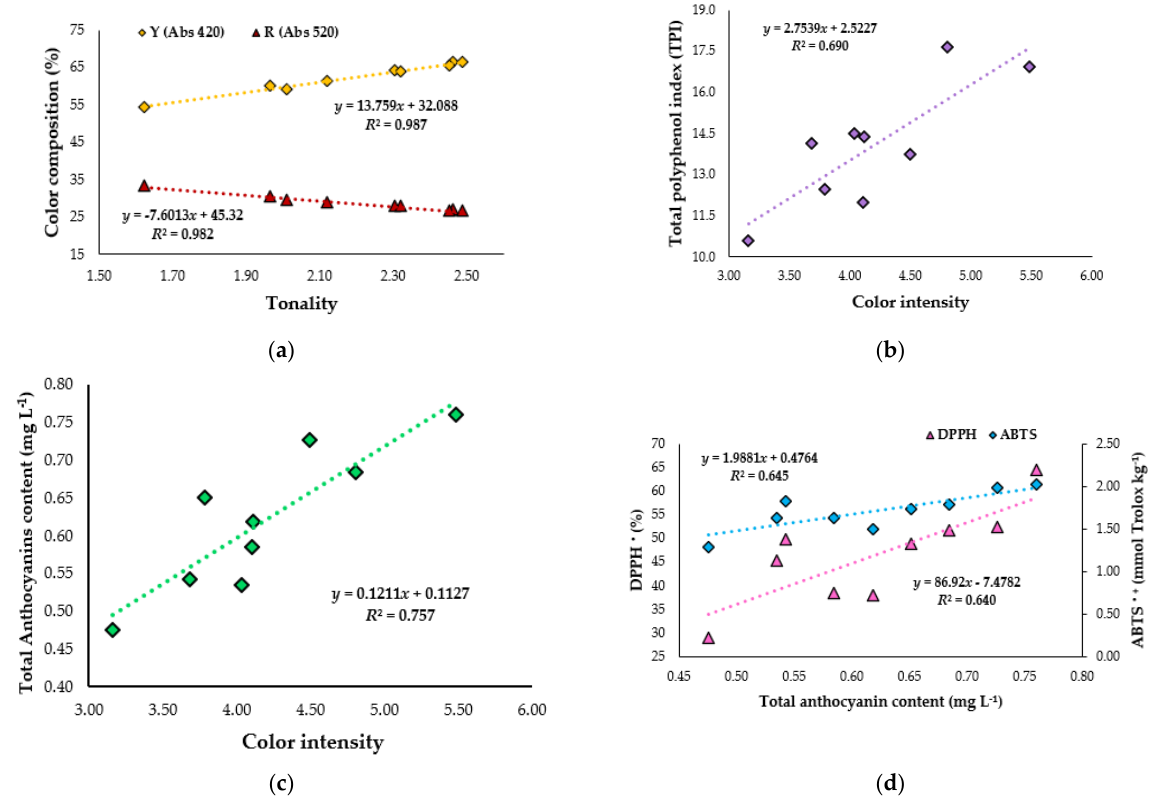
Figure 1. Correlation between color composition ( Y , R ) and tonality ( a ); correlation between color intensity and phenolics index ( b ); correlation between color intensity and total anthocyanins ( c ); and correlation between total anthocyanins content and antioxidant activity (ABTS •+ , DPPH • ) ( d ).